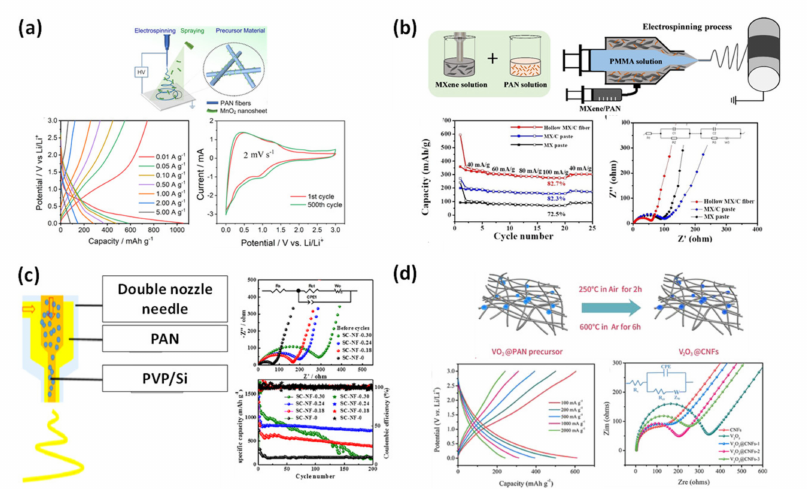
Figure 13. ( a ) Lithium-ion battery using CNF-decorated MnO 2 nanosheets for anode material [96]. ( b ) Anode constructed from CNFs containing MXene used for lithium-ion battery [97]. ( c ) Hollow CNF-embedded Si nanoparticles on inner wall [98]. ( d ) CNFs/urchin-shaped V 2 O 5 particle for lithium-ion battery electrode